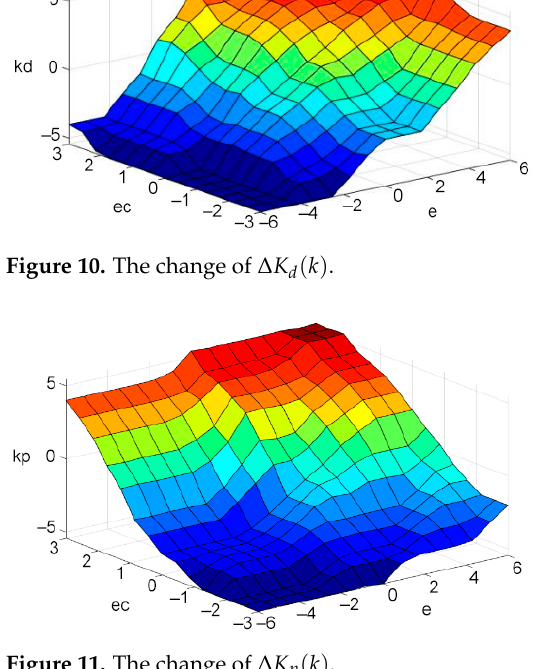
Figure 11. The change of ∆ K p ( k ) .